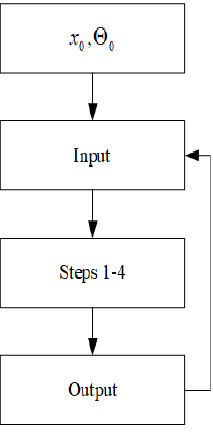
Figure 5. Closing-loop system